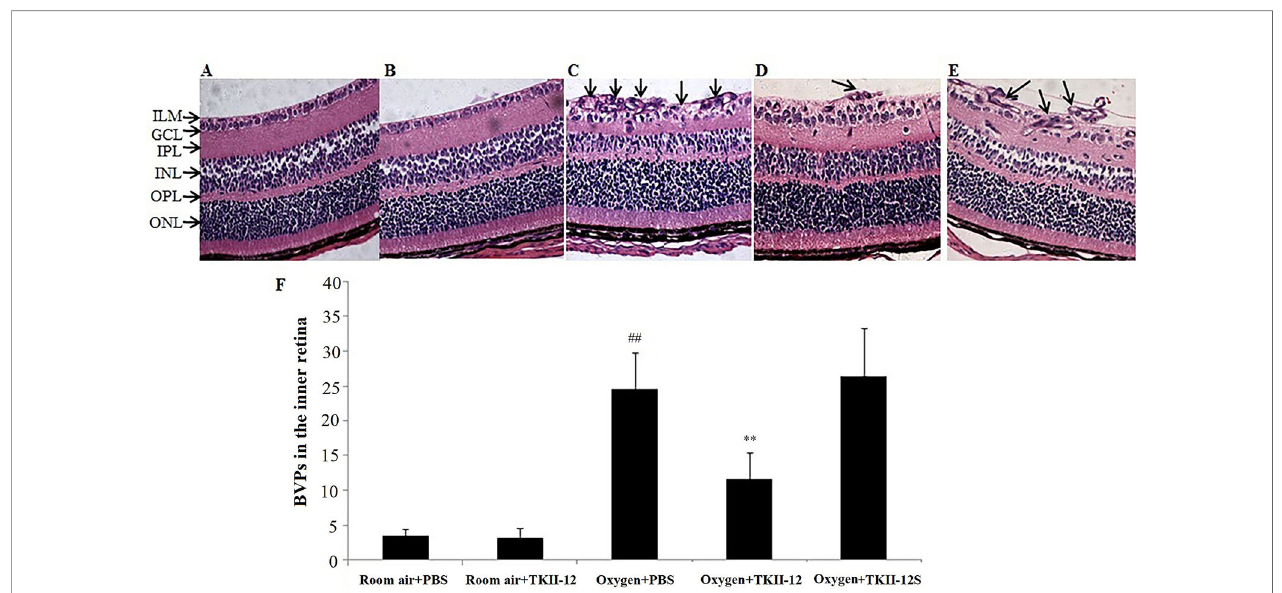
FIGURE 8 | Inhibitory effect of TKII-12 on oxygen-induced retinopathy in mice. Paraf fi n-embedded sections of the retina stained with hematoxylin and eosin. (A) Room air plus phosphate-buffered saline (PBS); (B) room air plus TKII-12; (C) oxygen plus PBS; (D) oxygen plus TKII-12; (E) oxygen plus the scrambled peptide. Arrows: blood vessel pro fi les (BVPs) in the inner retina or extending from the retina into the vitreous cavity. Magni fi cation, ×100. (F) Quanti fi cation of BVPs in the inner retina. ## p < 0.01 versus the room air plus PBS group. ** p < 0.01 versus the oxygen plus PBS group.